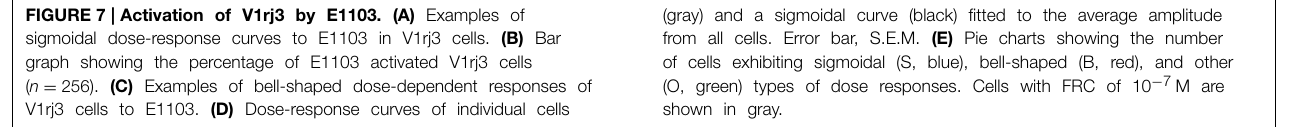
(gray) and a sigmoidal curve (black) fitted to the average amplitude from all cells. Error bar, S.E.M. (E) Pie charts showing the number of cells exhibiting sigmoidal (S, blue), bell-shaped (B, red), and other (O, green) types of dose responses. Cells with FRC of 10 − 7 M are shown in